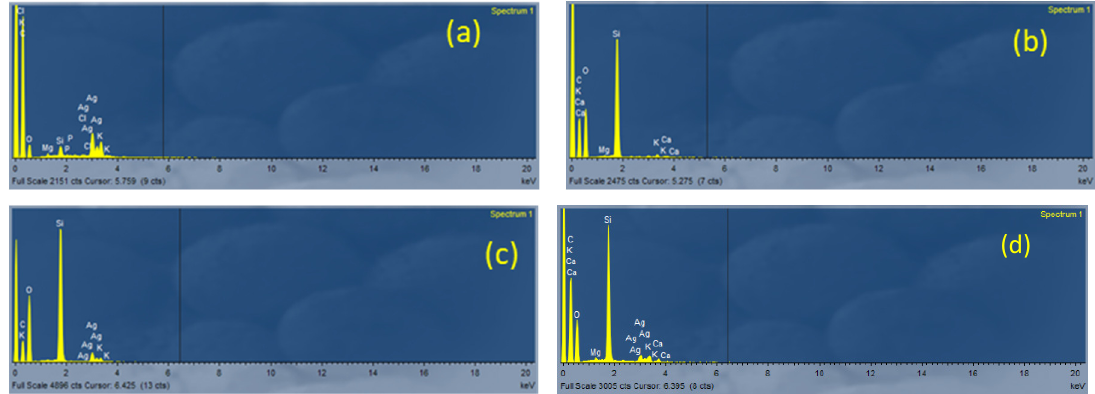
Figure 2. Energy-dispersive X-ray spectroscopy (EDX) analysis of the prepared biochars; ( a ) RHB400, ( b ) RHB550, ( c ) RHB700 and ( d ) RHB850. Table 1. % Atomic concentration of elements of the studied biochars determined by the EDX analysis.